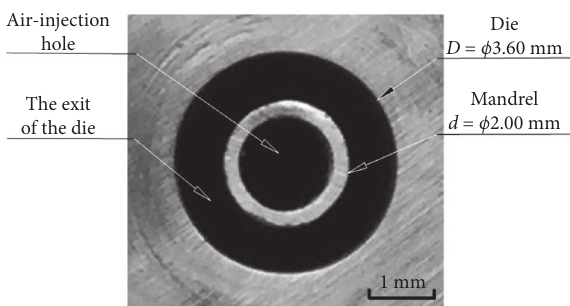
Figure 2: Graphics of micro-coextrusion die